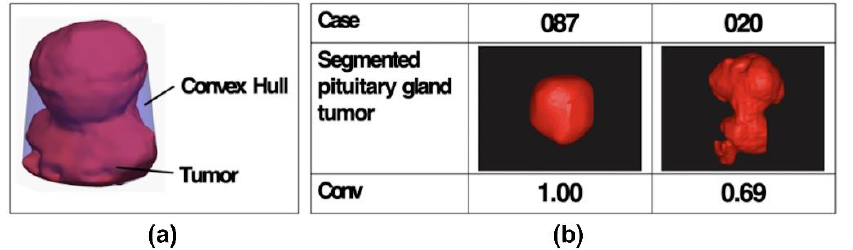
Figure 3. ( a ) 3D rendering (in purple) of convex hull of a pituitary gland tumor. ( b ) Examples of pituitary gland tumor with different Conv values: from high (left side) to low (right side).